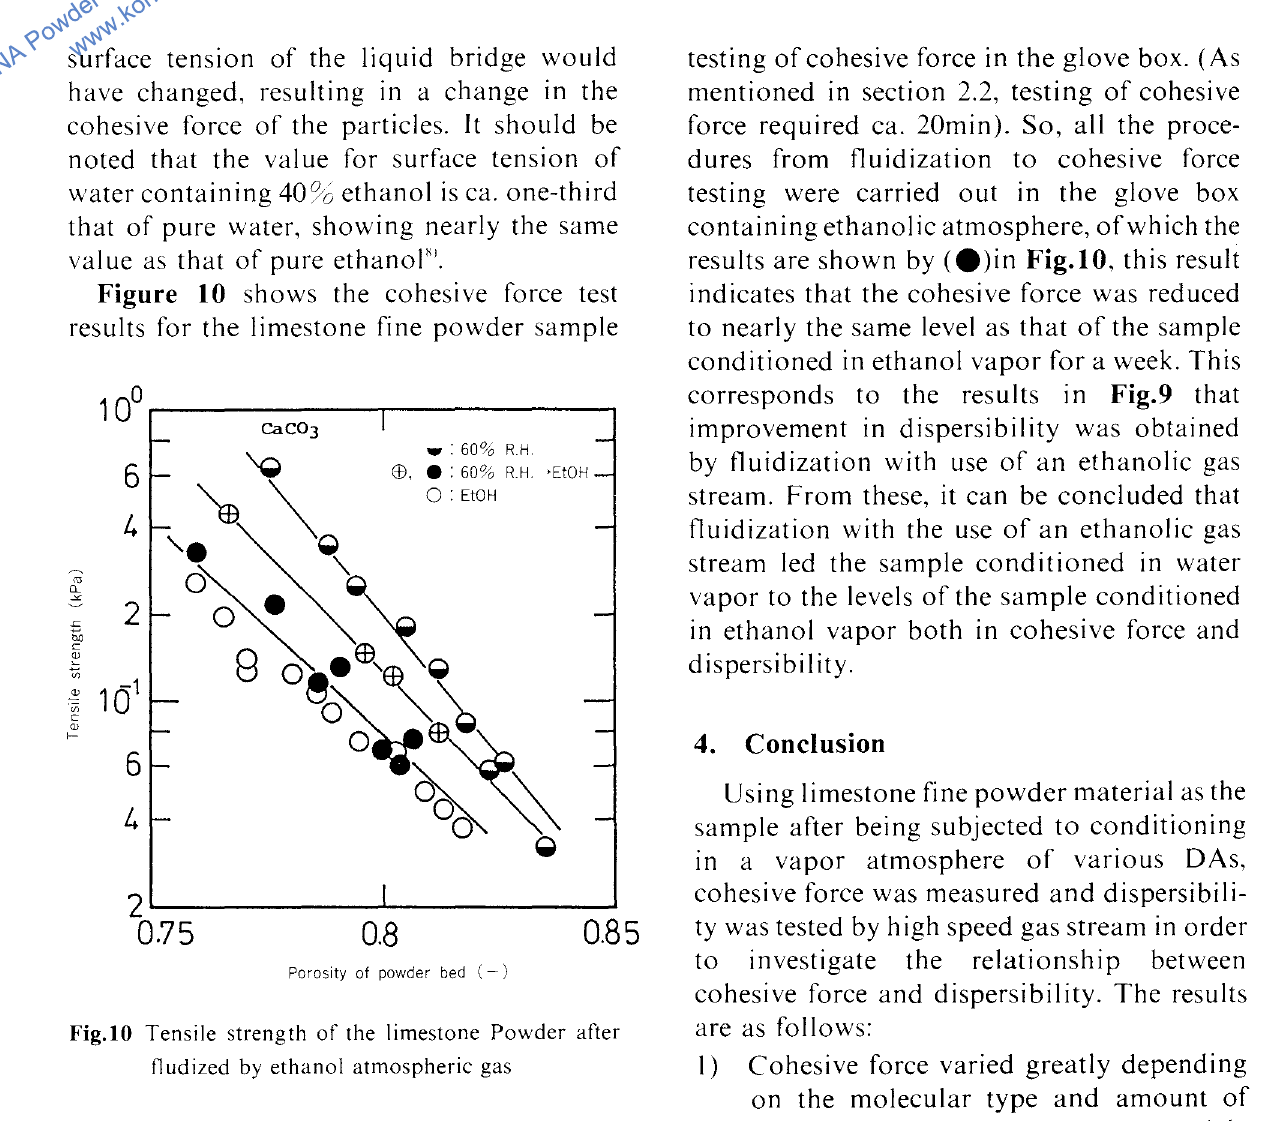
Fig.IO Tensile strength of the limestone Powder after fludized by ethanol atmospheric